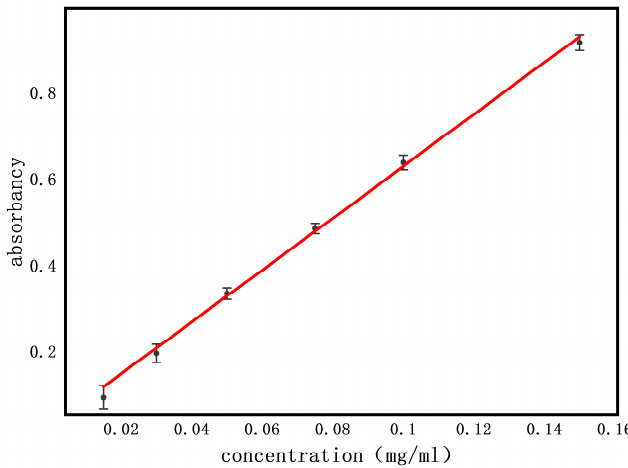
Figure 7. The standard curve of ROX.